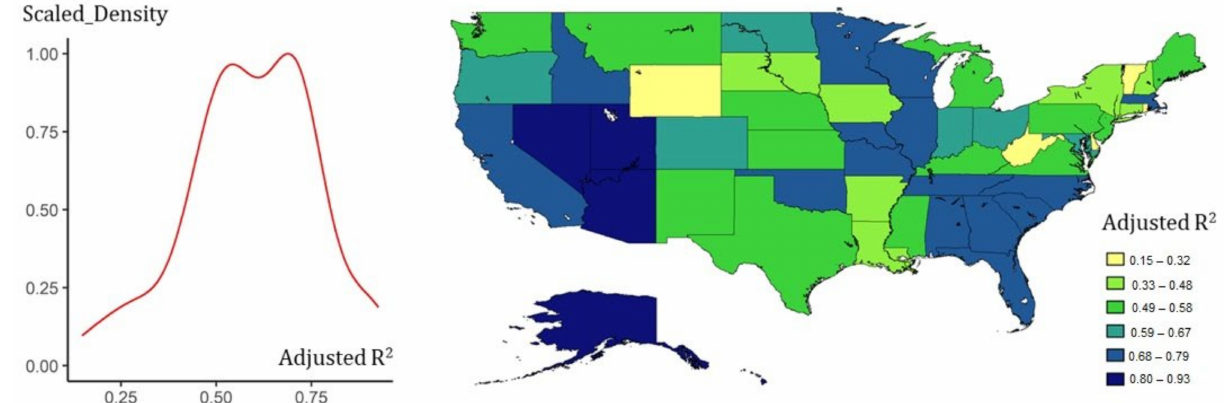
Figure 2. State-level fitness of Equation (8) with county-level data. The scaled density curve of adjusted R 2 shows that Equation (8) was generally applicable, and its mapping indicated that the potential spatial heterogeneity of the states would affect the results of the SIRu modeling. Among them, the states in the southeastern, the west coast, and the Great Lakes Region showed higher adaptability.